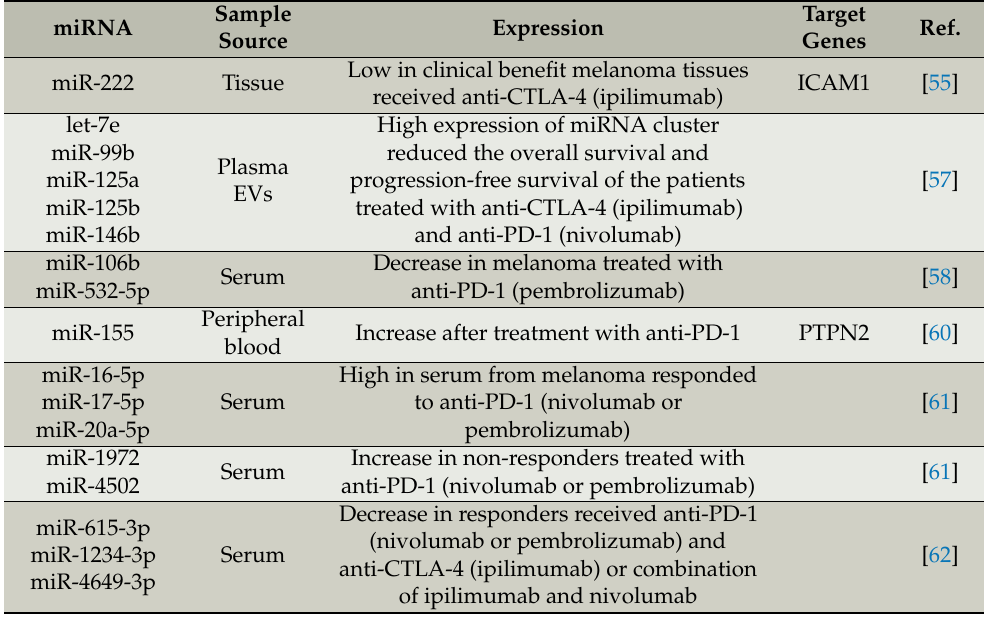
Table 1. miRNAs as predicted biomarkers for